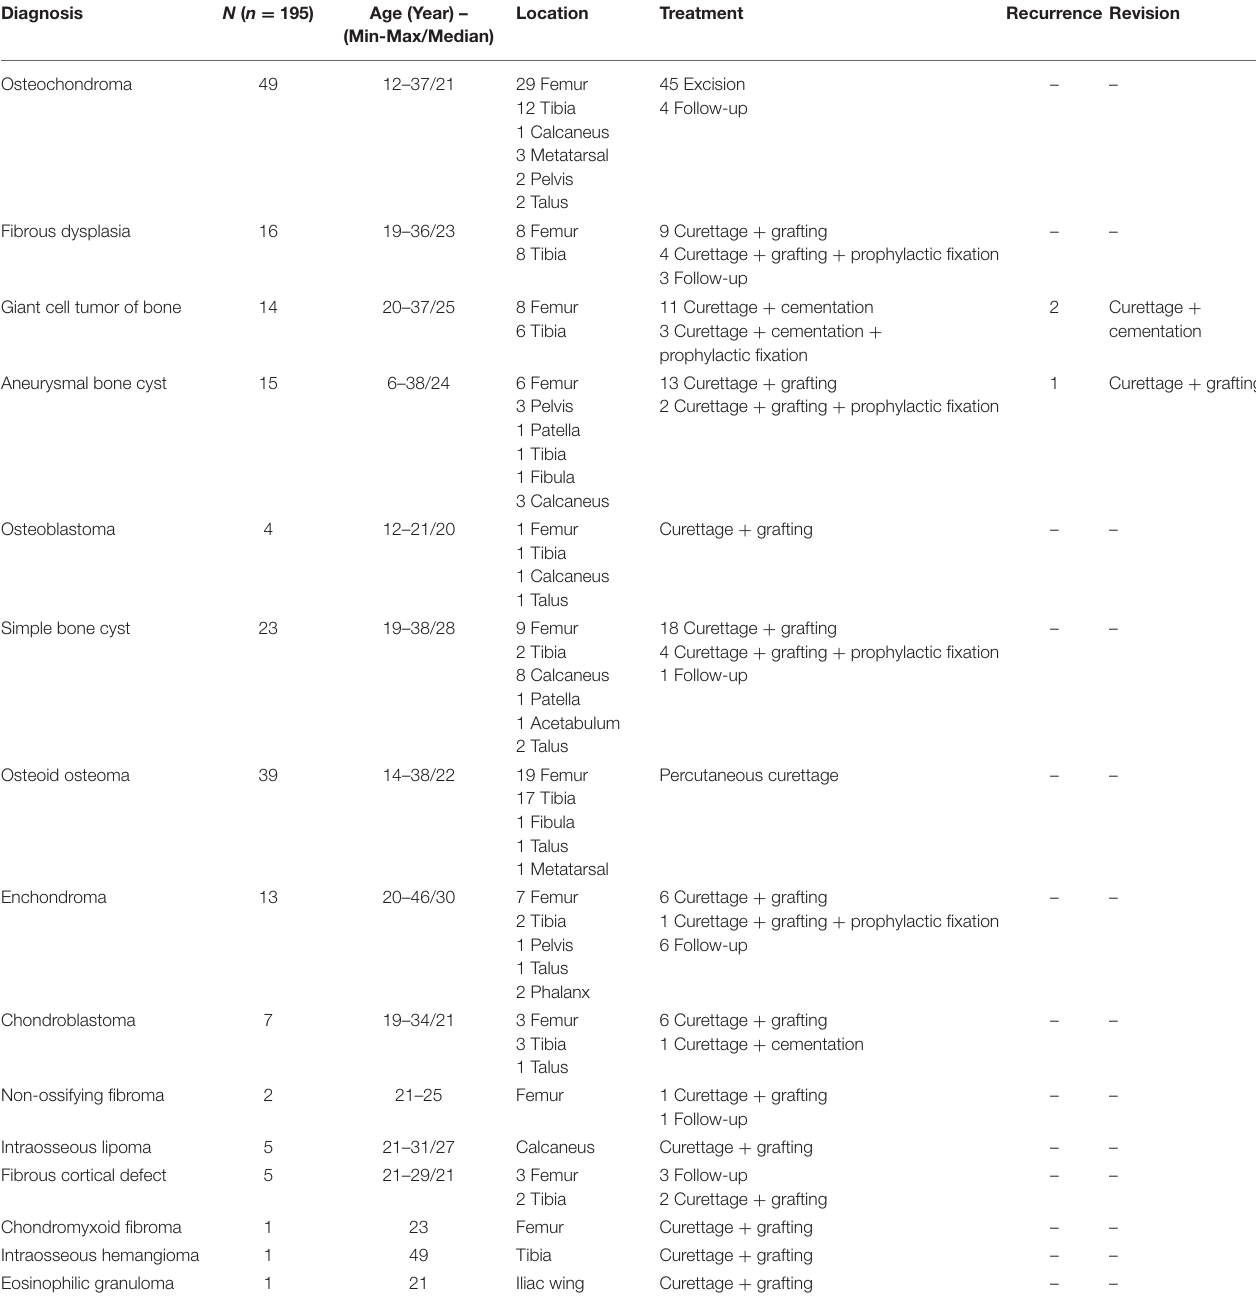
TABLE 8 | Benign bone tumors of the lower